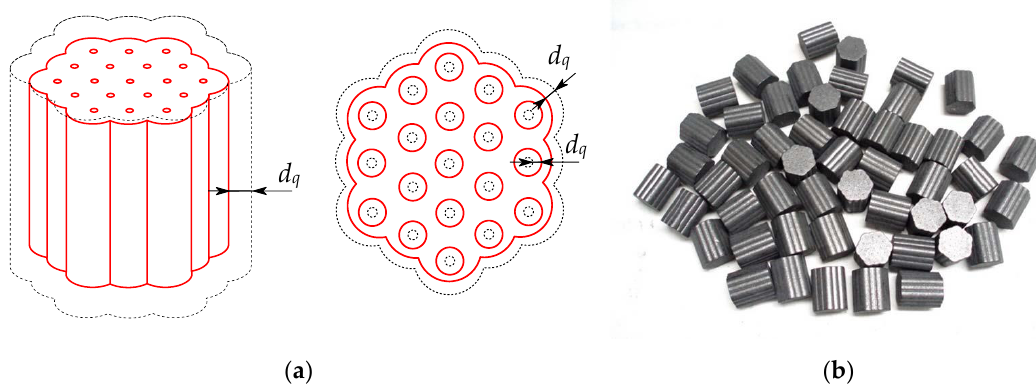
Figure 5. Images of 19-perforation rosette grains: ( a ) scheme of the geometry of a grain where the initial surface (dotted line) and the instantaneous surface (red line) can be seen, showing the definition of the normal burning distance; ( b ) image of the propellant used for the modular charge tests.